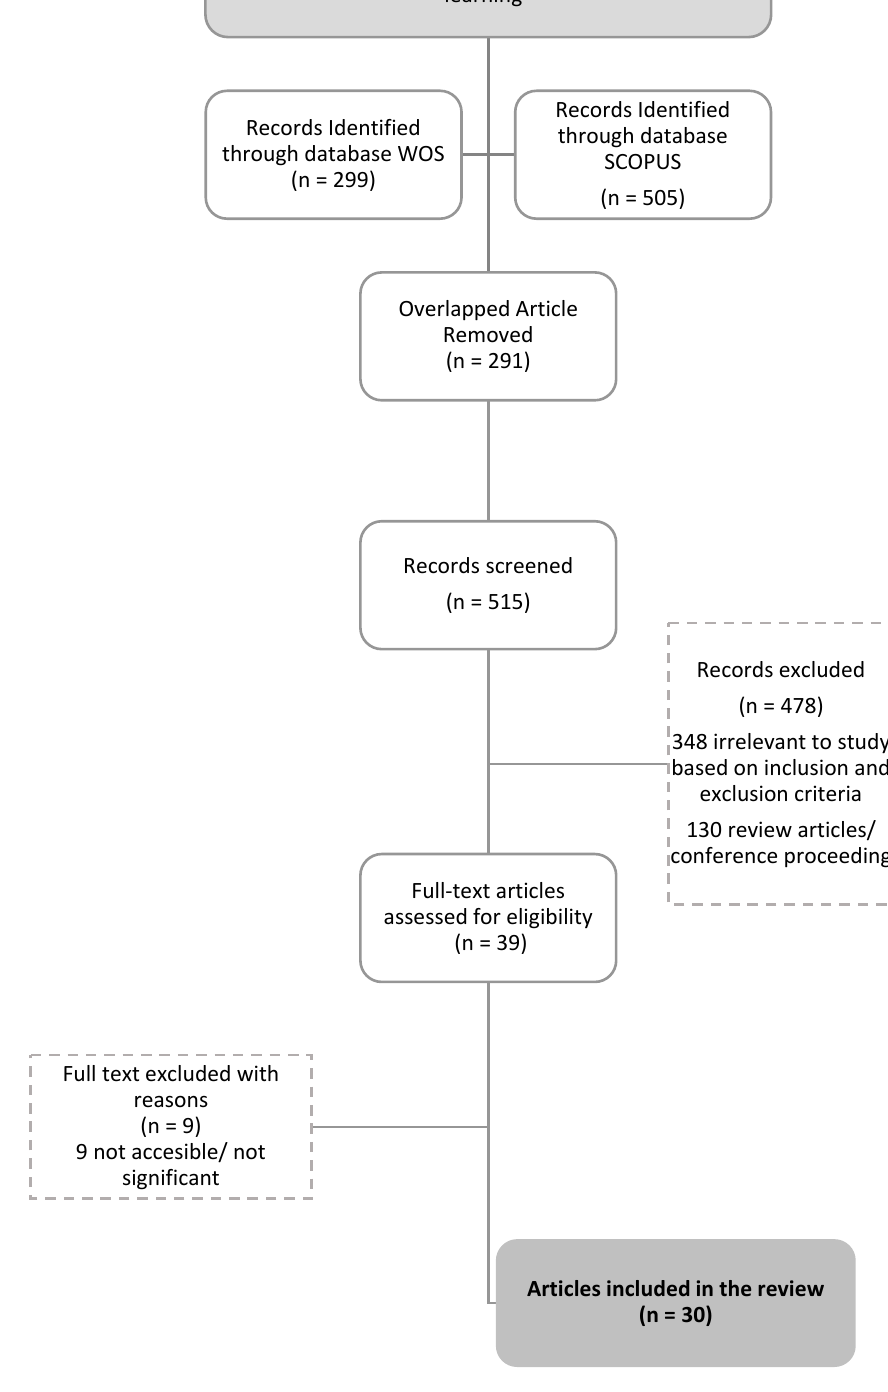
Figure 1. The PRISMA flow diagram of the entire procedure for selecting reviewed articles.